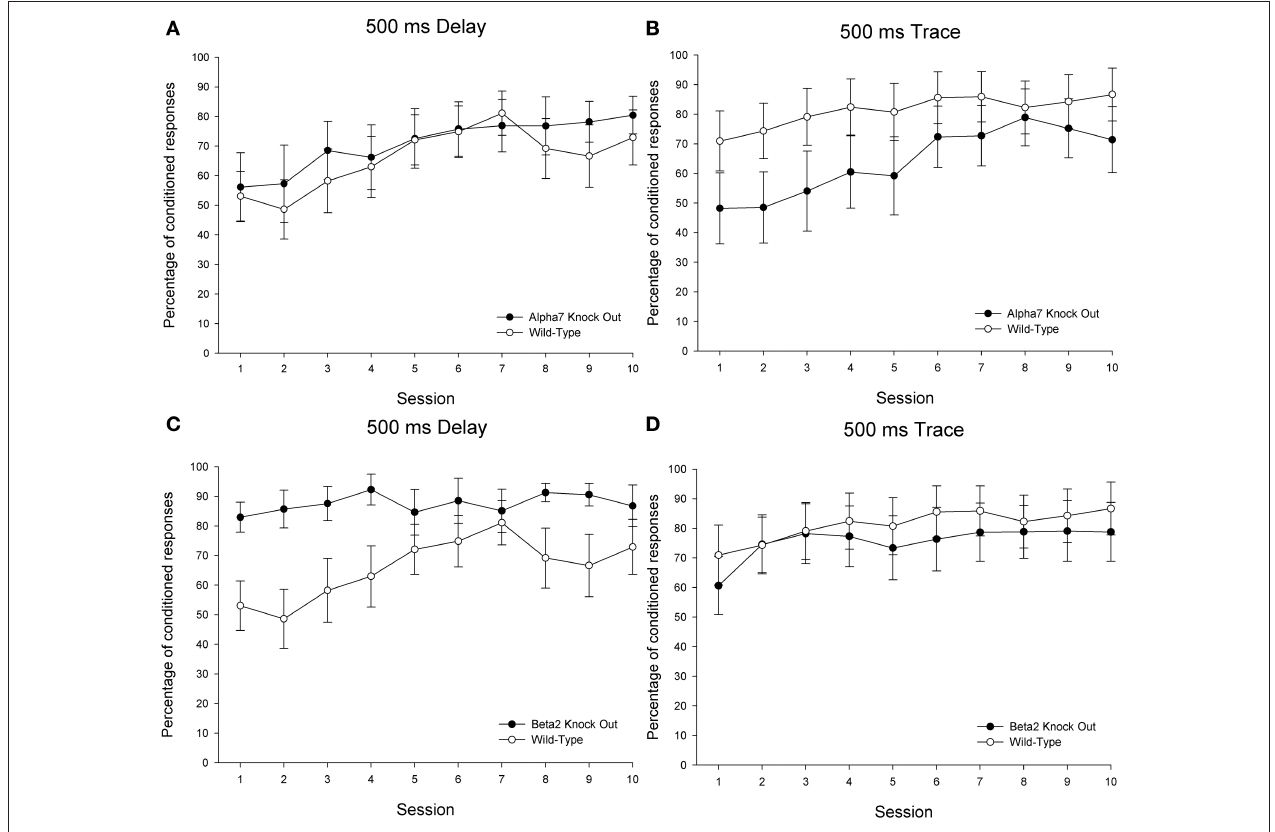
Performance in the 90 paired trials/session is shown here. Delay eyeblink conditioning is depicted on the left side and trace eyeblink conditioning is shown on the right. Comparisons between wild-type controls and α 7 KOs are shown on the top (A,B) panels, while comparisons between wild-type controls and β 2 KOs are shown across the bottom (C,D) panels. The error bars indicate standard error of the